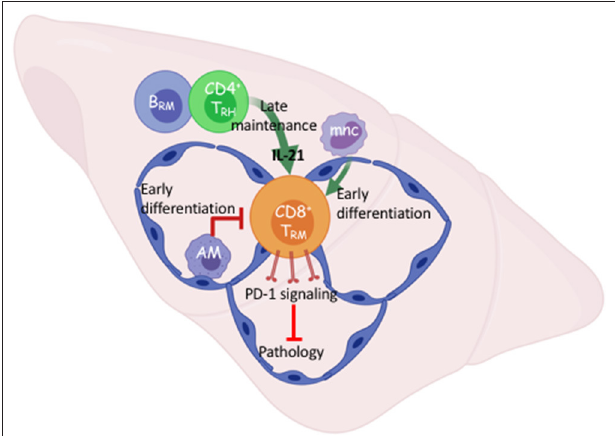
FIGURE 1 | Early and late cellular networks involved in Trm cell differentiation and maintenance. After viral respiratory pneumonia, early pulmonary CD8 T RM cell differentiation is driven by re-encounter with antigen presented via interstitial classic monocytes (mnc) and opposed by alveolar macrophages that maintain lung homeostasis. B cell-dependent tissue-resident CD4 helper T cells (T RH ) support T RM cell maintenance through IL-21 dependent survival. T RM intrinsic PD-1 signaling prevents pathology in the absence of infectious virus. Created with BioRender.